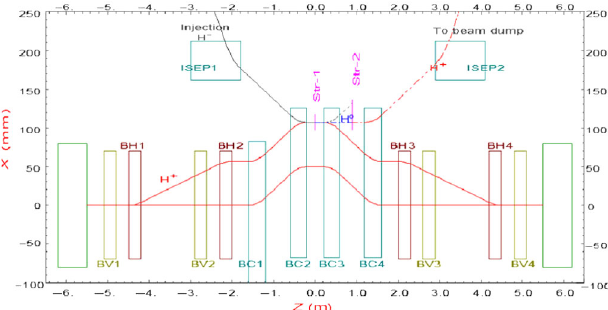
FIG. 1. The schematic diagram of the injection